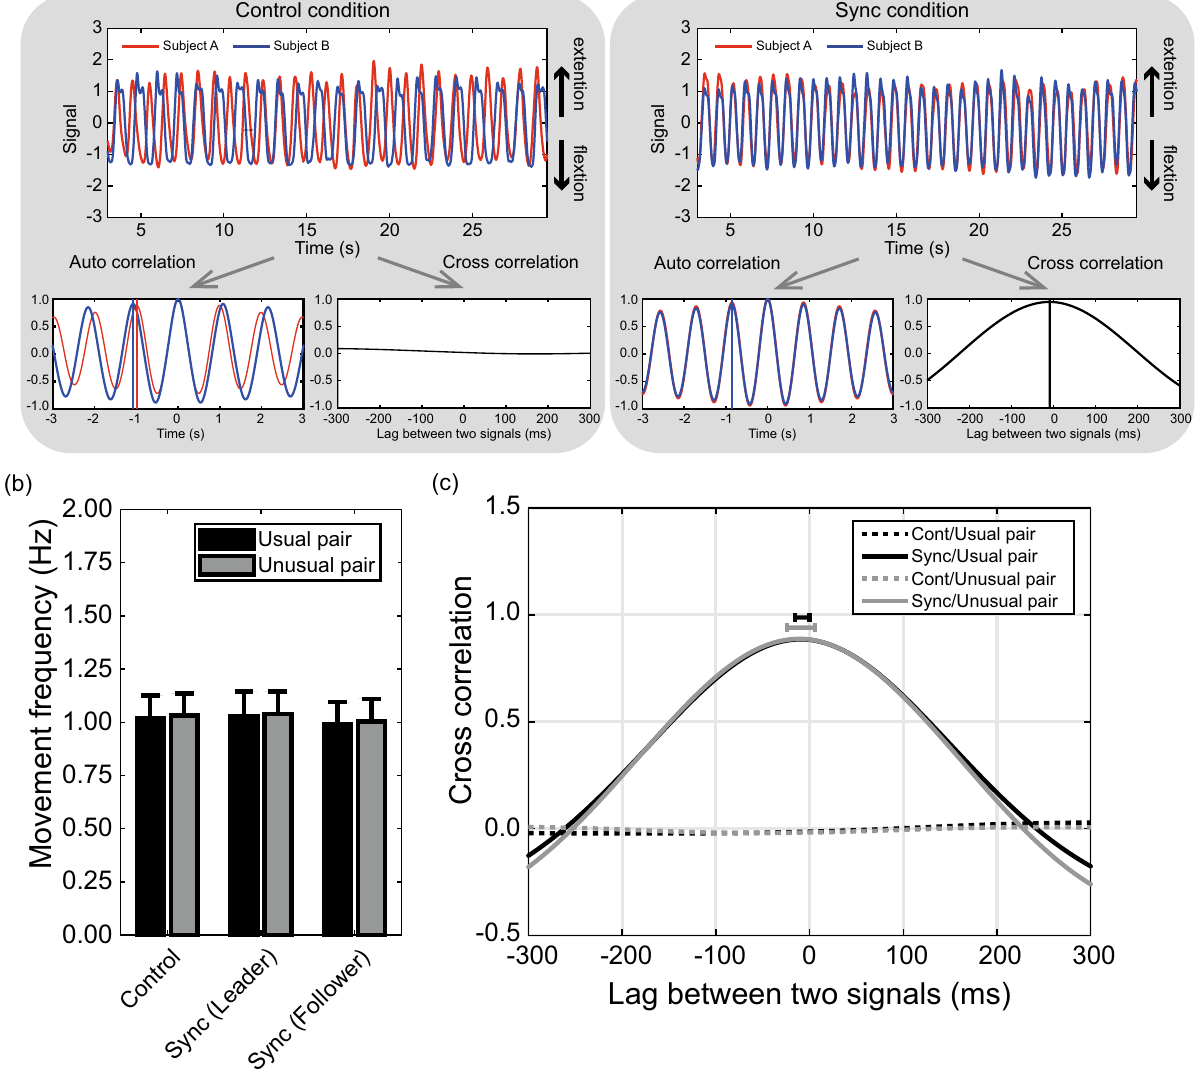
Figure 1. Behavioral results. ( a ) Typical example of wrist movement data. For each condition, the normalized wrist movement data and the results of the auto correlation and cross correlation in a representative trial of a pair are shown. In the results of the auto correlation, a vertical solid line indicates the first peak latency of the auto correlation curve. In the results of the cross-correlation, the vertical solid line indicates the latency of the peak value of the cross-correlation curve. An explicit peak of the cross-correlation curve was not observed in the base condition because the wrist movements of two participants were not temporally synchronized. Therefore, the solid vertical line was not depicted on the cross-correlation curve in the base condition. ( b ) Wrist movement frequency was identified by the first peak of an auto correlation curve. The error bars in the bar graph represent standard errors. ( c ) Grand-averaged cross-correlation curve. The positive value of the lag indicates that the leader led the movements of the follower; contrarily, a negative value of the lag indicates that a follower led the leader’s wrist movement. In sync trials, standard deviations for a time lag of the peak of curves are represented as horizontal error